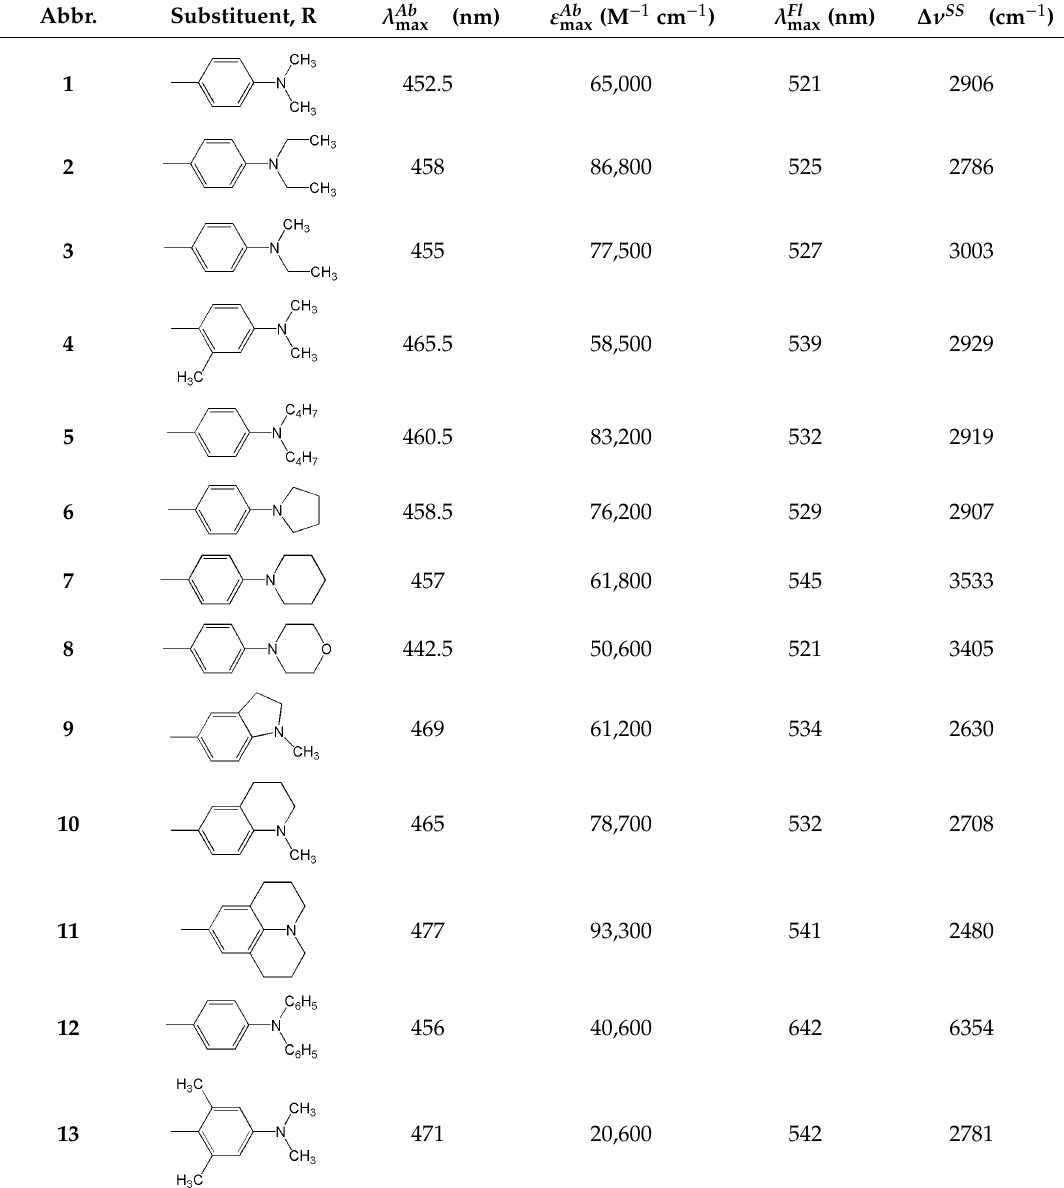
Table 1. The photophysical data a) for compounds 1 – 13 .